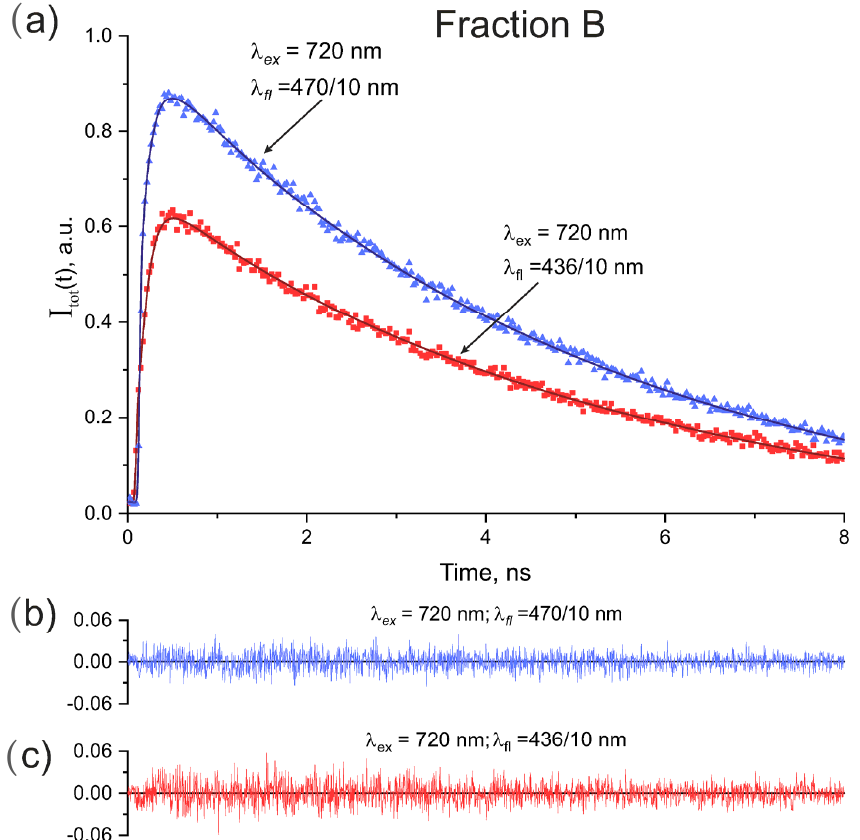
Figure 5. ( a ) Polarization-insensitive fluorescence decay curves in fraction B under two-photon excitation at 720 recorded through the fluorescence spectral windows of 470/10 nm and 436/10 nm. Experimental signals are given with blue and red dots and solid lines are fits. ( b , c ) residuals used for control of the fit quality.